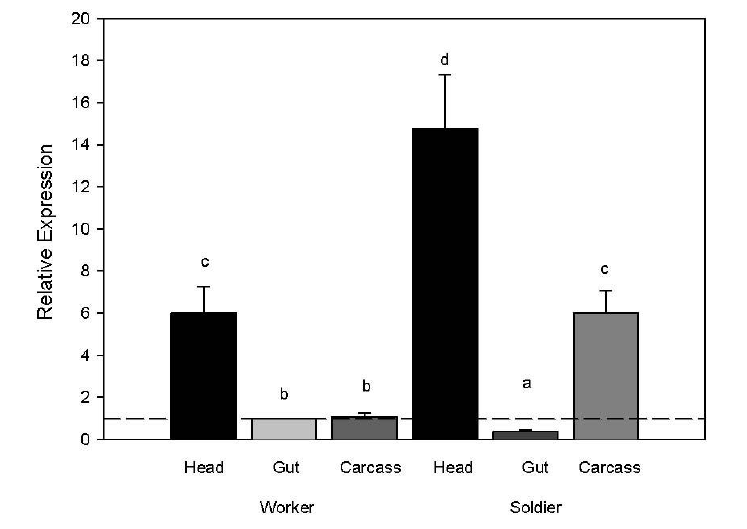
Figure 3. Myosin transcript abundance in relation to caste and body region. Expression values for target genes were normalized to the expression values from the reference gene ( RPL32 ) and then to the target genes for worker guts. A two-way ANOVA was used to separate significant expression differences with a Tukeys HSD test for separating means by treatment for each caste and body region ( p <